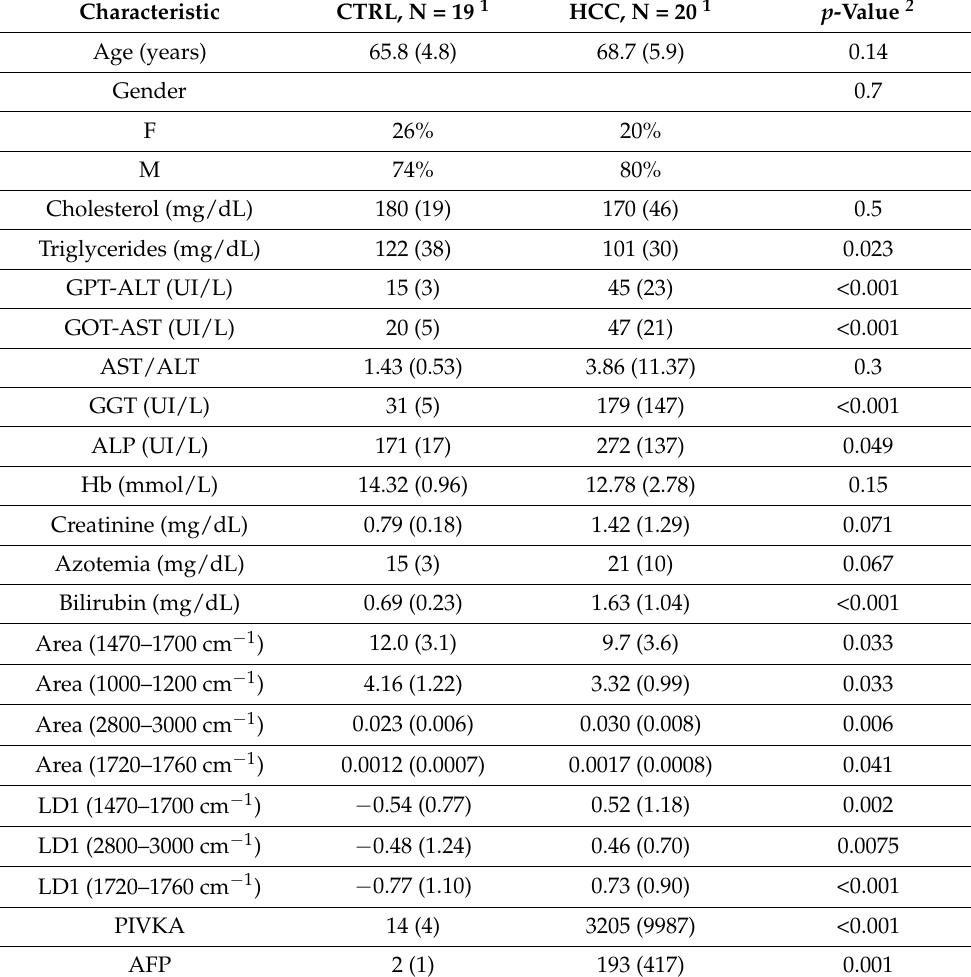
Table 1. Demographical, clinical, biochemical, and spectral characteristics of the recruited subjects.